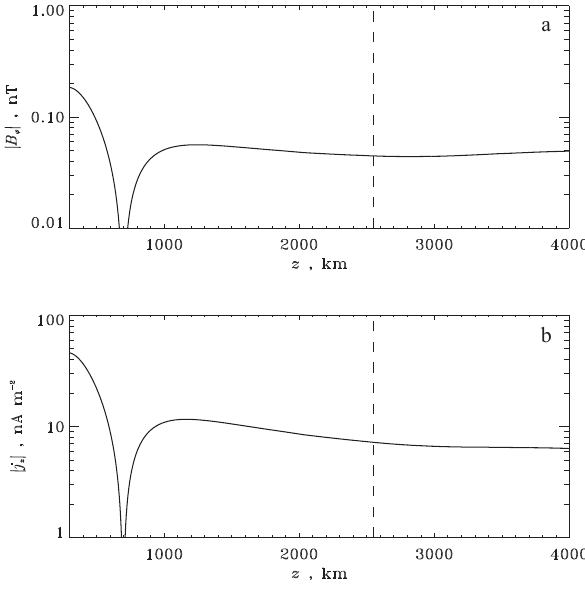
Fig. 8. Variation with height of amplitudes ( a ) of the transverse magnetic field | B ϕ | and ( b ) the field-aligned current | j z |